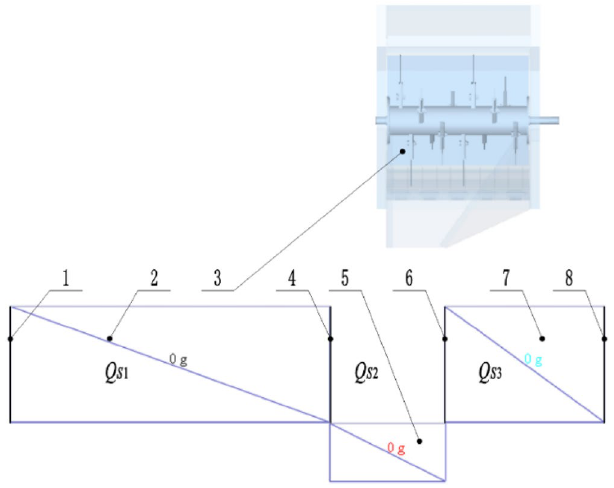
Figure 5. Simulation sensors setup. ( 1 ) baffle I, ( 2 ) square sensor I, ( 3 ) smashing and scattering device, ( 4 ) baffle II, ( 5 ) square sensor II, ( 6 ) baffle III, ( 7 ) Square sensor III, ( 8 ) baffle IV.